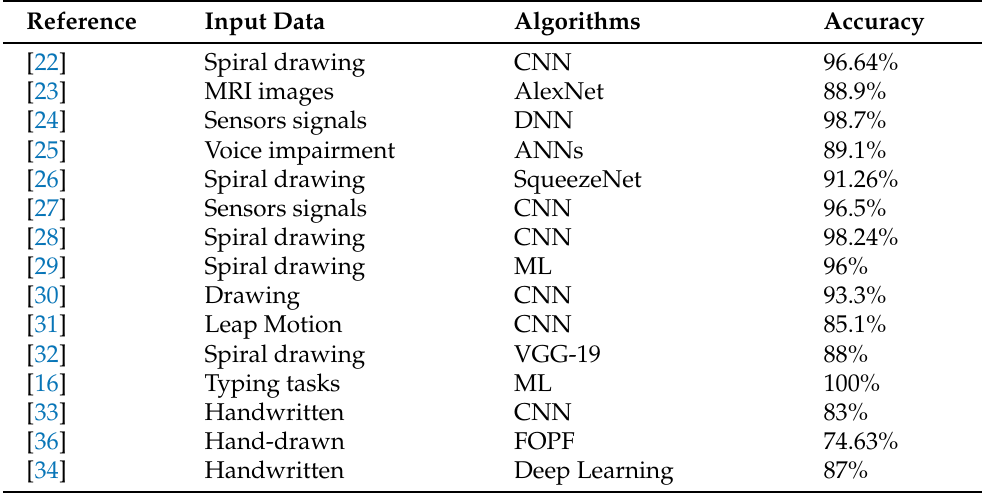
Table 1. Summary of the identified related work.